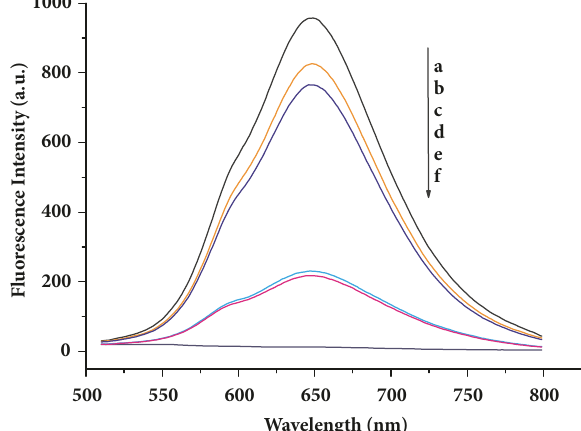
Figure 1: Fluorescence emission spectra of AuNCs-BSA in the absence(a)andpresenceofCu 2+ (f).Fluorescencerecoveryfromthe quenched AuNCs-BSA by adding of GSH (b), cysteine (c), glycine (d), and glutamic acid